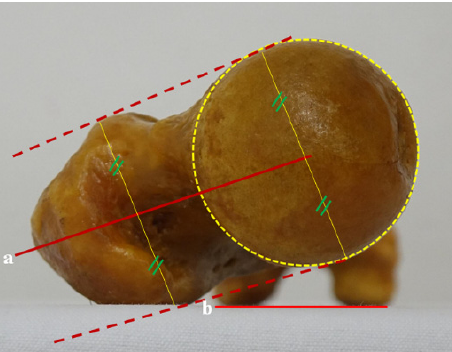
Figure 3. Femoral anteversion angle using the head-to-greater trochanter (H-G) line: (a) (H-G line) the solid center line between two dotted lines that connects the anterior and posterior borders of the femoral head and the greater trochanter; (b) the connecting line of the posterior border of both femoral